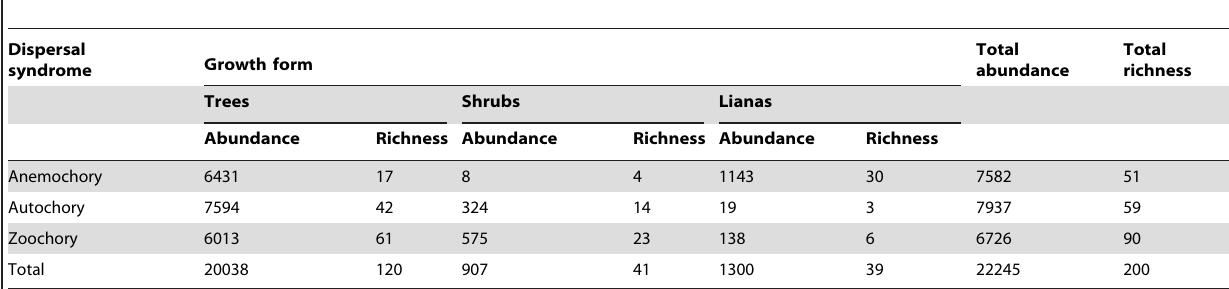
Table 1. Species richness and abundance of woody plants by growth form and dispersal